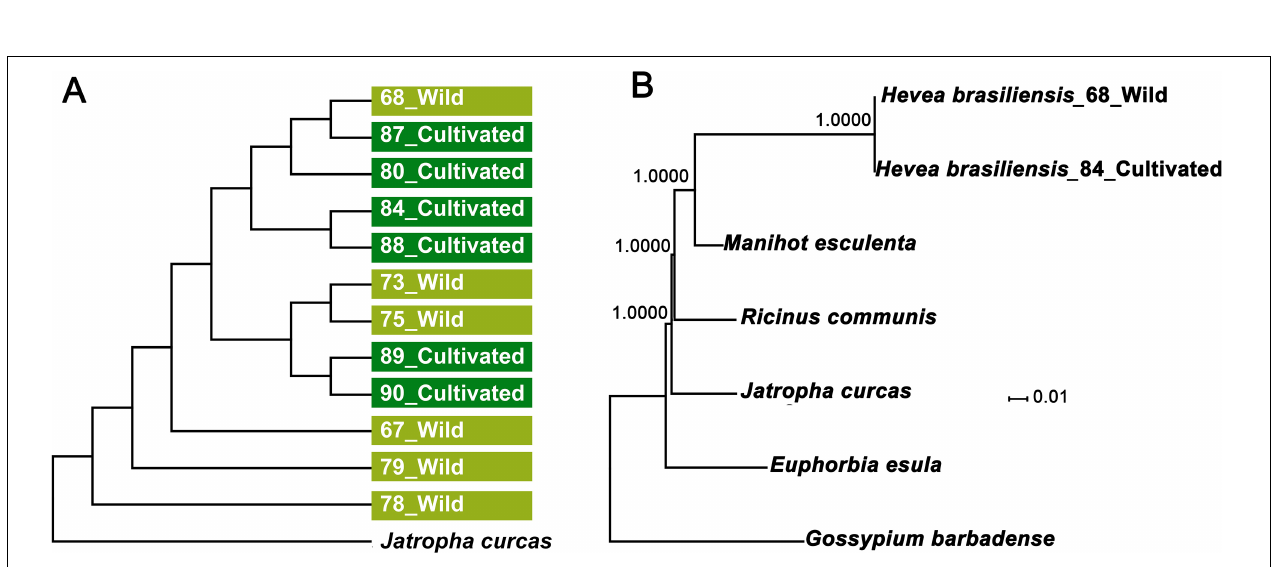
FIGURE 6 | Phylogenetic analyses of the 12 H. brasiliensis accessions and the five Euphorbiaceae species. (A) Phylogenetic tree of the 12 H. brasiliensis accessions inferred from complete nucleotide sequences of the chloroplast genomes; (B) ML phylogenetic tree of the five Euphorbiaceae species.